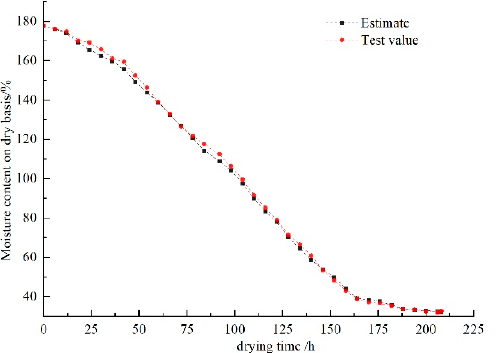
Figure 4. Verification comparison of apricots using the Wang and Singh drying model. As seen in Figure 4, all predicted p values were >0.05, indicating that there was no sig- nificant correlation between the experimental and predicted values. The MR experimental data corroborated the optimized Wang and Singh model data and had an error value of 0.05, indicating good regression. Therefore, the Wang and Singh model best explained the model for drying apricots under natural